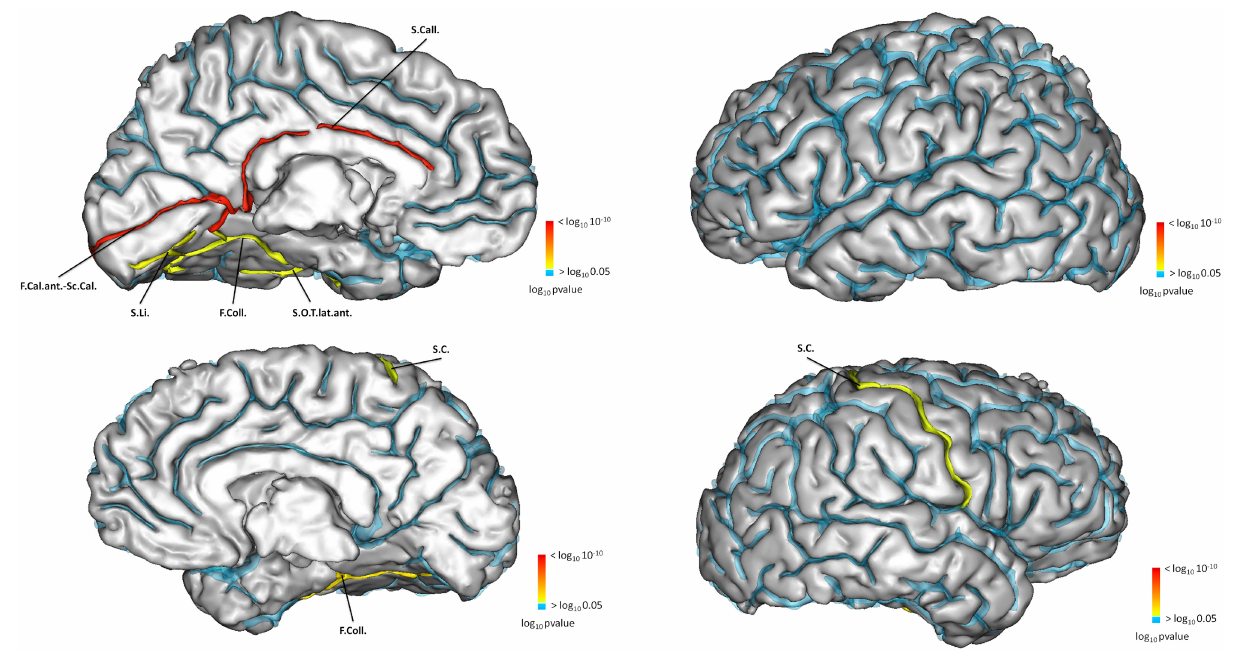
Ammonis are rudimentary structures situated in the postero- medial wall of the lateral ventricles (Humphrey, 1967). At 13 GW, the hippocampus goes from the frontal lobe to the temporal lobe on the postero-medial wall of the lateral ventricles, and surrounds